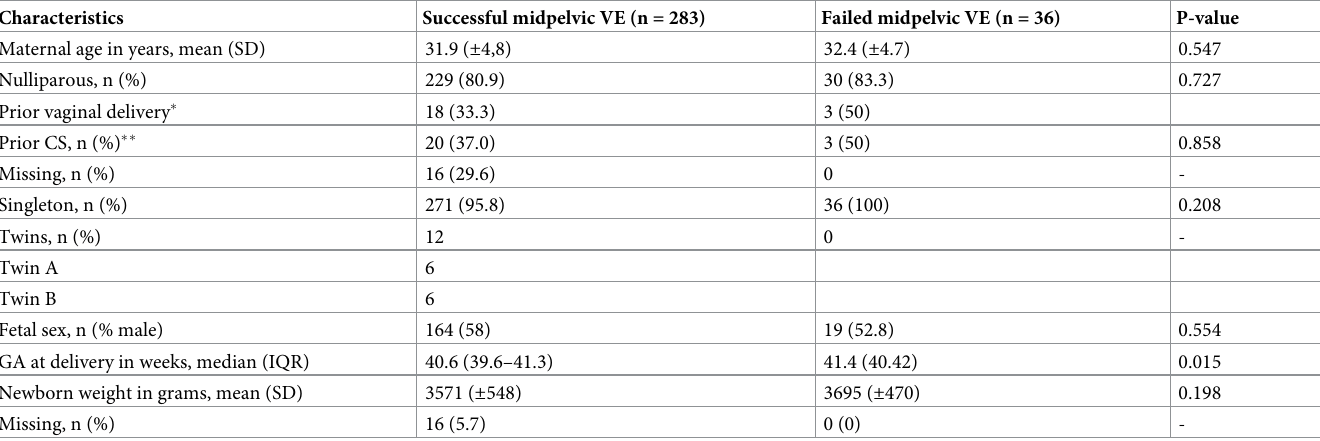
Table 1. Maternal and neonatal characteristics in attempted midpelvic vacuum extractions (n = 319) categorized according to success or failure.